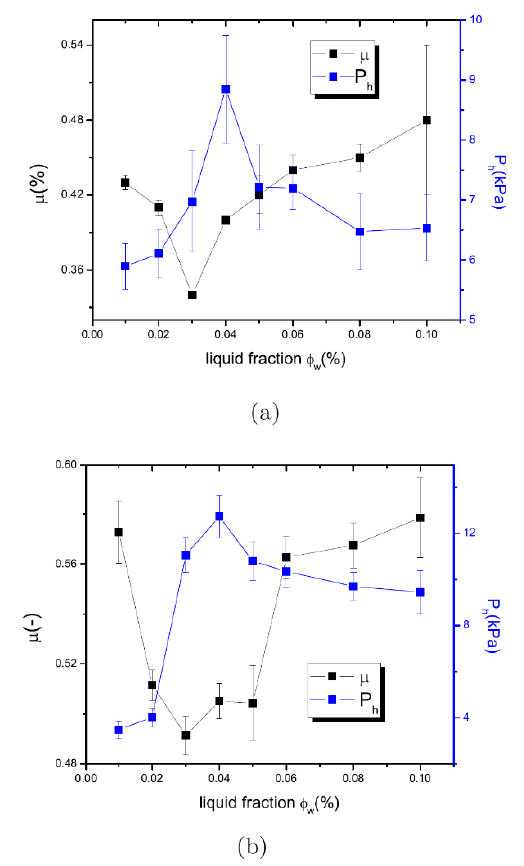
Fig. 4. Friction coefficient and penetration hardness vs. volume fraction of the interstitial liquid for glass beads and silicone oil mixture with (a) viscosity of 350mPa.s (b) with viscosity of 1000 mPa.s. The size of the glass beads is between 106 µm and 212 µm. the assembly with interstitial liquid with higher viscosity shows higher penetration hardness and friction coefficient. Above all of this we show that penetration hardness and friction coefficient act opposite each other. Stiffer media has low friction